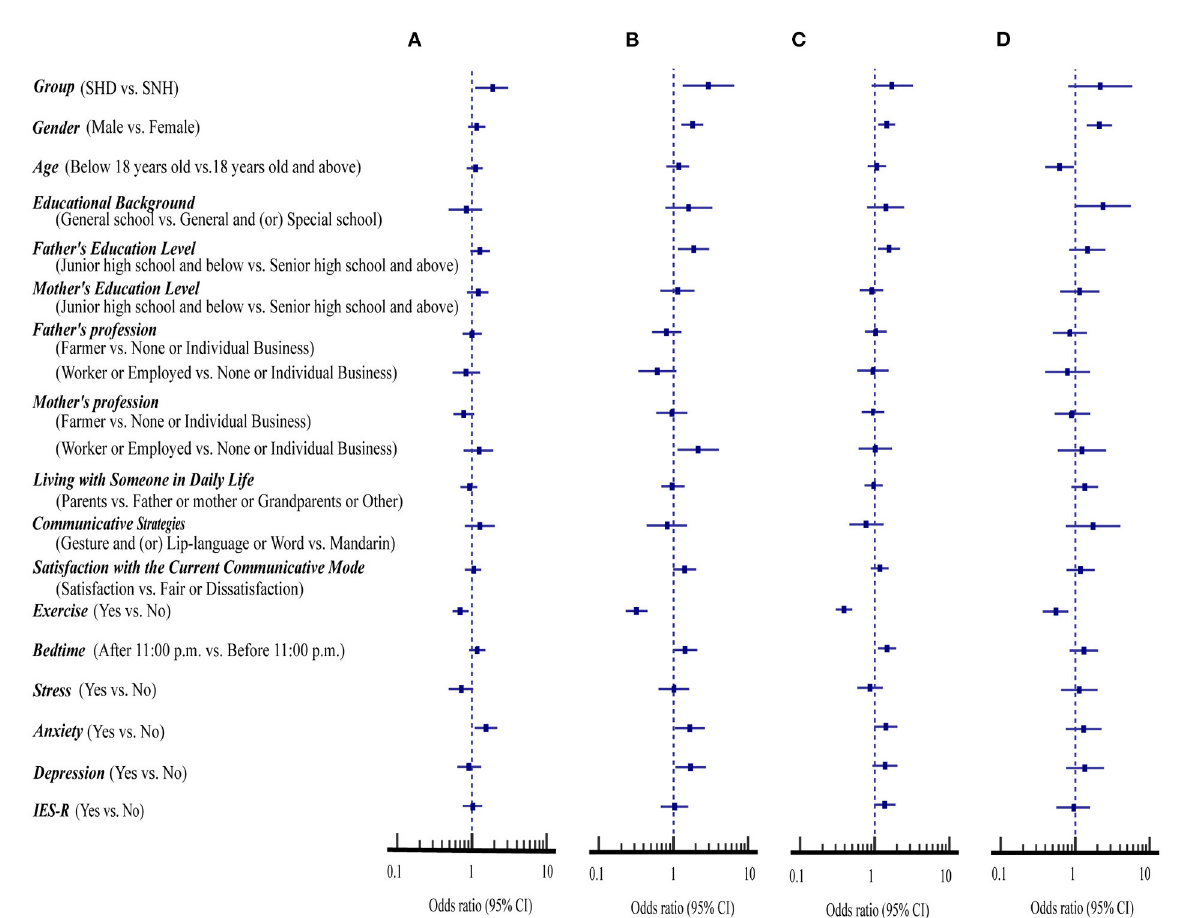
FIGURE3 Association of demographic variables, mental health status and psychological impacts with the compliance with four health measures in students with and without hearing disability ( n = 1,589). (A) Avoiding sharing of utensils during mealtime. (B) Washing hands with soap and water. (C) Washing hands immediately after coughing, or sneezing, rubbing the nose. (D) Wearing masks with or without the pandemic